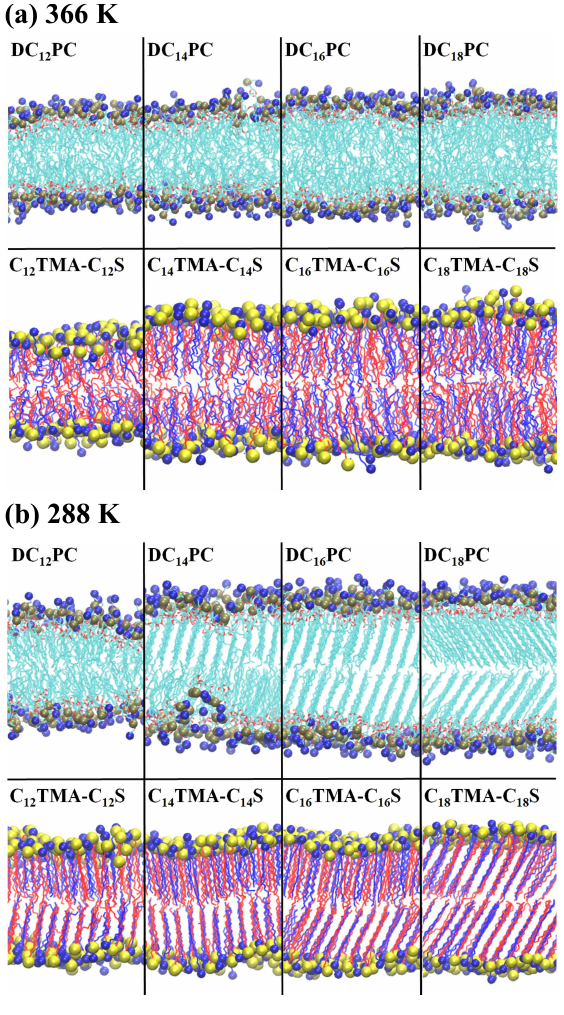
Figure 3. Simulation snapshots for PC and IPC systems with various alkyl chain length at ( a ) 366 and ( b ) 288 K. The atoms within the hydrophilic groups of IPA or PC are colored as follows: nitrogen is in blue, sulfur in yellow, and phosphor in tan. The alkyl chains from the cationic and anionic amphiphiles are colored in blue and red, respectively, to distinguish the two IPA components, whereas the PC alkyl chains are colored in cyan. Water is not shown for clarity. Figures were generated with VMD